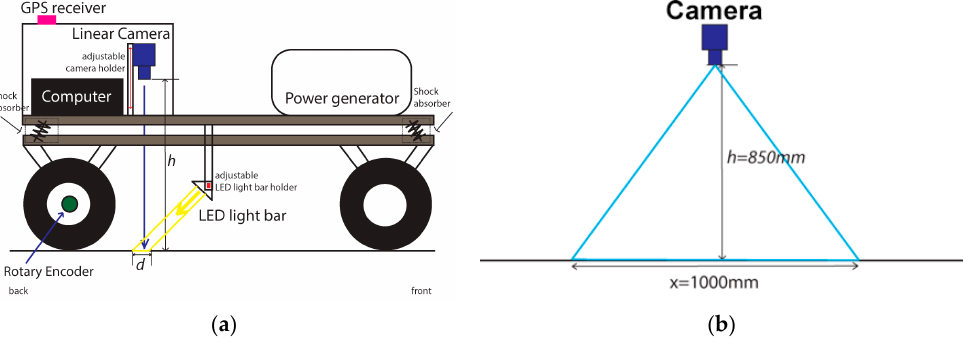
Figure 4. Diagrams of the developed scanner: ( a ) Complete device set with the blocks that makes the system; ( b ) Camera height and captured line